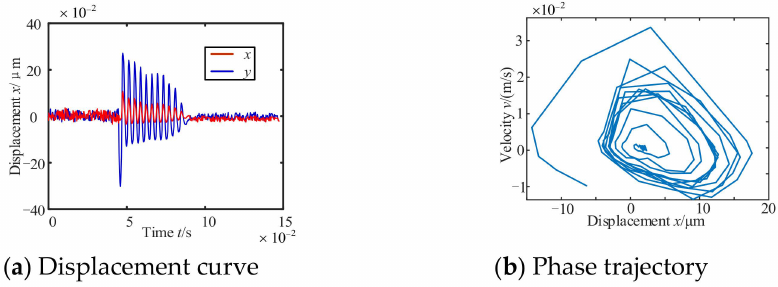
Figure 12. Displacement curve and phase trajectory under i 0 = 0.5 A.